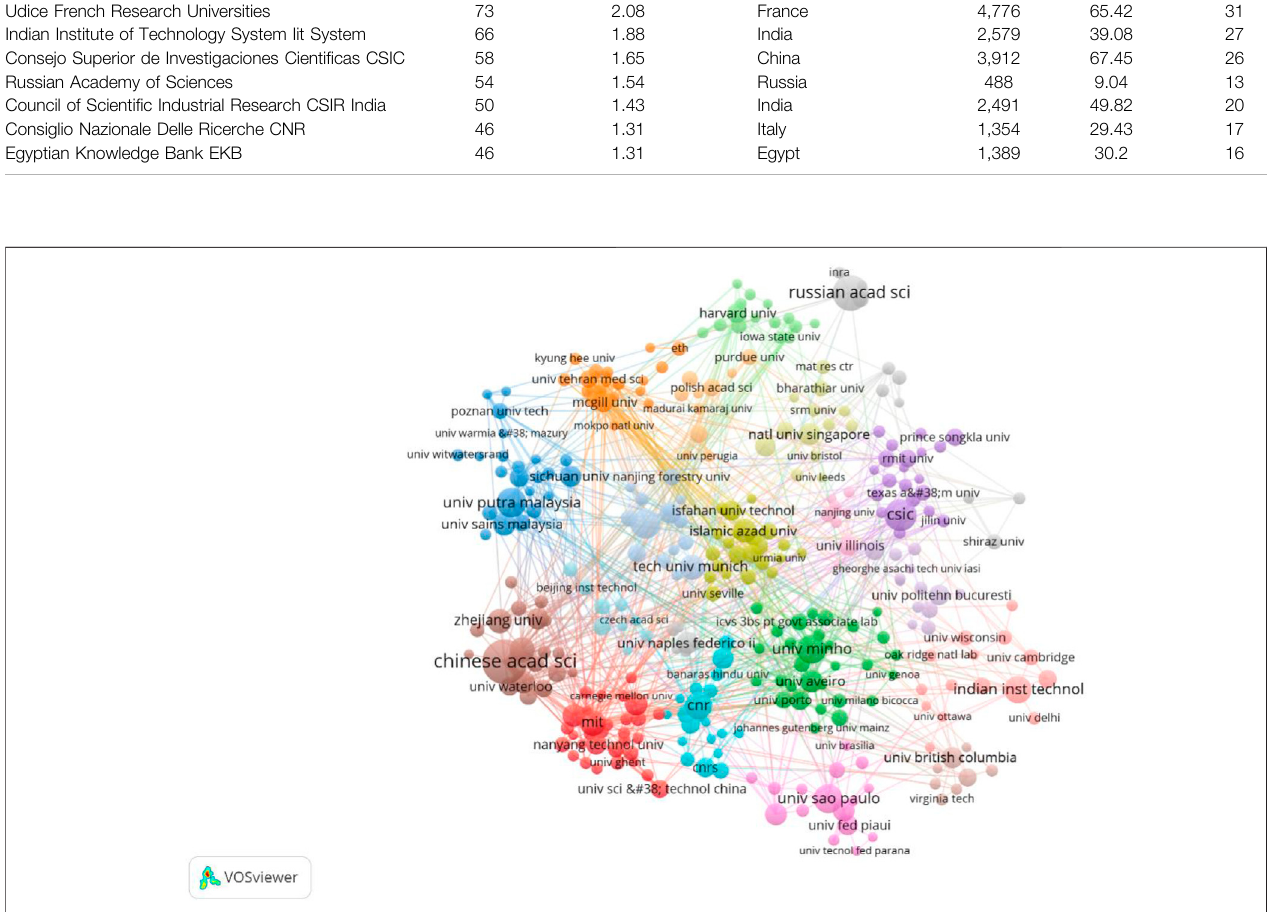
FIGURE 5 | Knowledge map of cooperation between institutions (frequency ≥ 5).